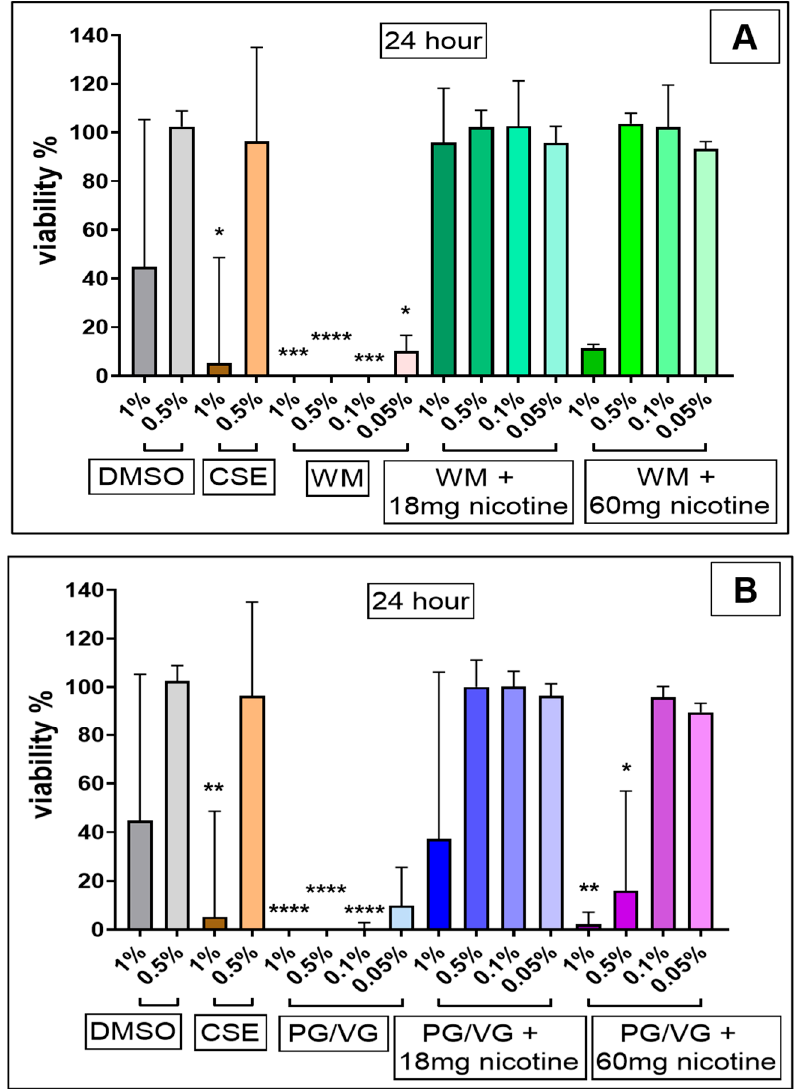
Figure 3. Viability of BEAS-2B cells following 24 h electronic cigarette aerosol and cigarette smoke exposure: Bronchial epithelial (BEAS-2B) cells were exposed to increasing concentrations (0.05%, 0.1%, 0.5% and 1%) of electronic cigarette condensate or cigarette smoke extract (CSE, 1% and 0.5%) for 24 h. Electronic cigarette condensates were generated from ( A ) watermelon (WM)-flavored e- liquid (Juicius Maximus) ± nicotine (18 mg/mL and 60 mg/mL); and ( B ) propylene glycol/vegetable glycerin (PG/VG) ± nicotine (18 mg/mL and 60 mg/mL). Viability was measured in cells treated for 24 h using a CCK-8 assay and is presented as percent viability in comparison with cell control. Data are displayed as median with interquartile range of n = 3–4 independent experiments. Kruskal– Wallis test with Dunn’s multiple comparison test was performed. * p < 0.05; ** p < 0.01; *** p < 0.001; **** p < 0.0001.